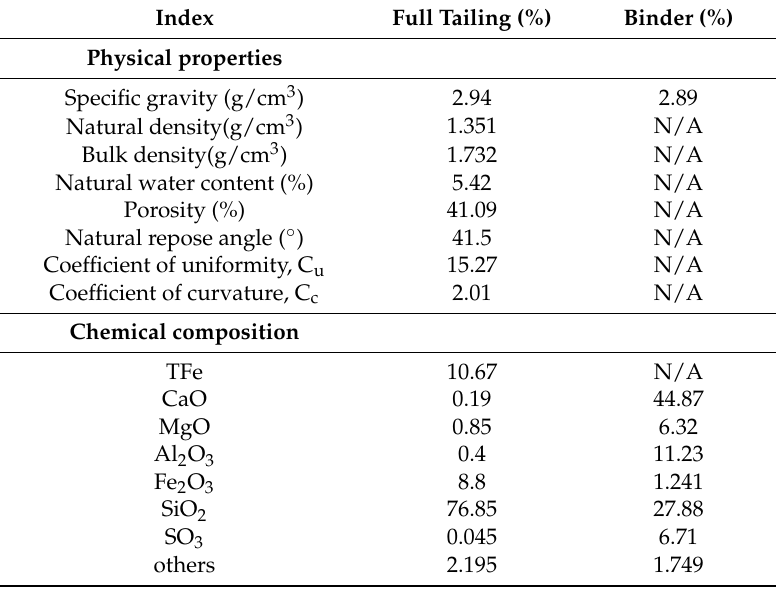
Table 1. The basic physical and chemical parameters of the Lilou full